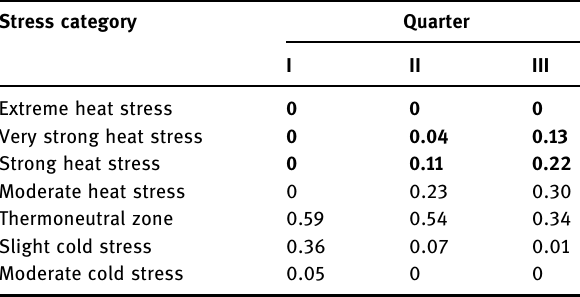
Table 5: The probability of heat stress for measurements taken in the fi rst quarter, second quarter and third quarter of the